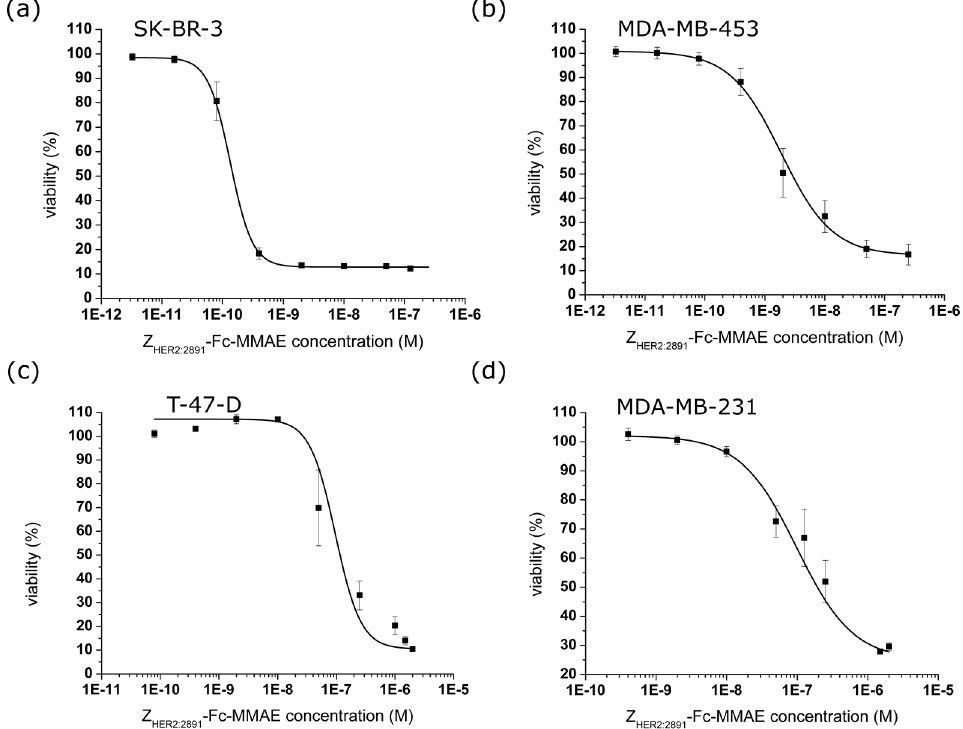
Figure 5. Cytotoxicity of the Z HER2:2891 -Fc-MMAE conjugate. The conjugate was tested on four breast cancer cell lines: ( a ) SK-BR-3 (HER2+); ( b ) MDA-MB-453 (HER2+); ( c ) T-47-D (HER2-) and ( d ) MDA-MB-231 (HER2-). Error bars represent standard error of the mean (SEM).